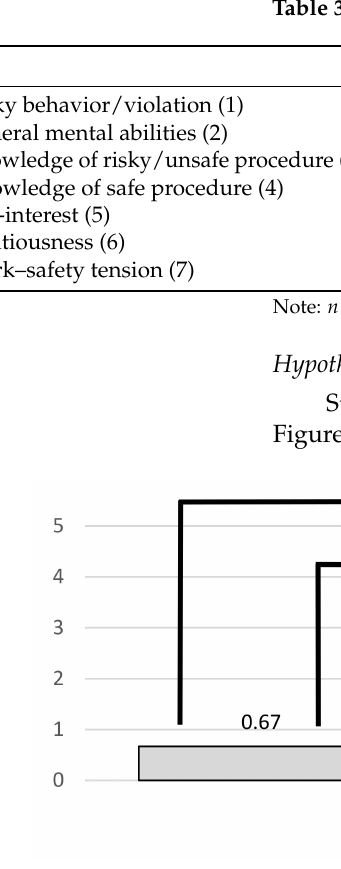
Figure 3. Mean number of risky behaviors/violations (0–36) in conditions of continuous, up-front, and bonus pay, highlighting significant differences between conditions. Note: * p <